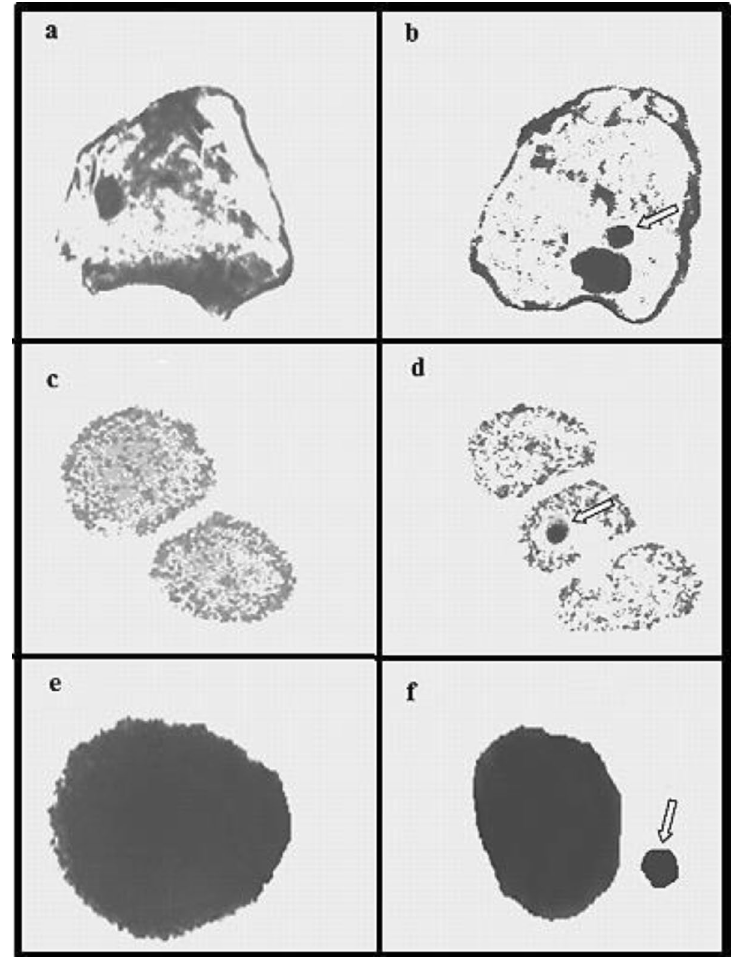
Figure 1. MN formation induced by Paraquat in different cells. Buccal mucosal epithelium normal appearance ( a ), buccal mucosal epithelium with MN ( b ), erythrocyte cell normal appearance ( c ), erythrocyte cell with MN